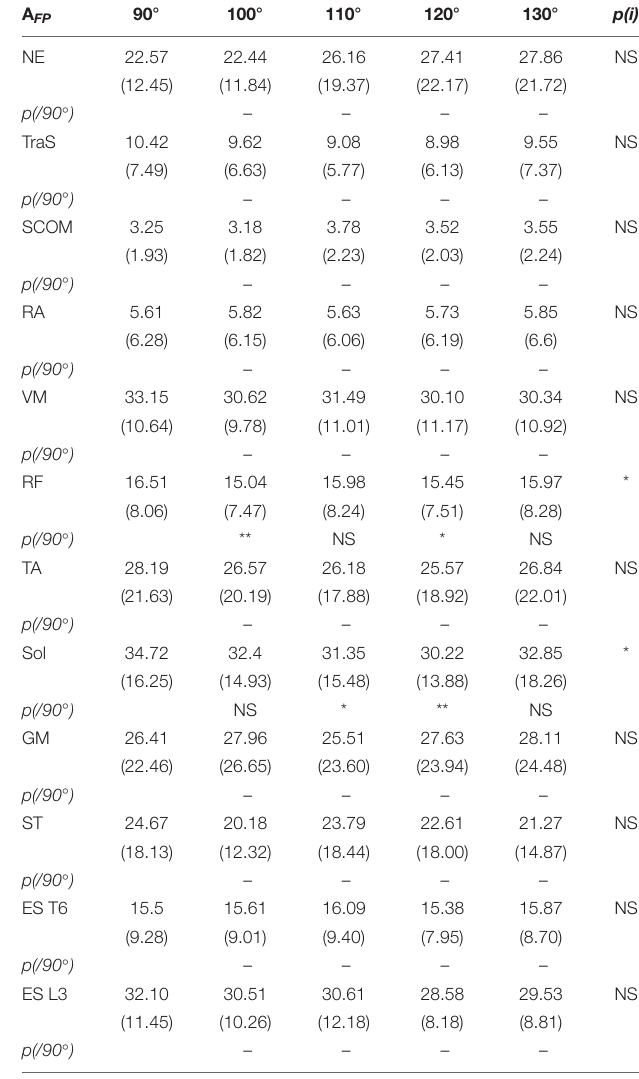
TABLE 3 | Mean (SD) muscle activity levels in the focal phase (A FP ), in % MVC, for the 5 inclination conditions, calculated for both execution